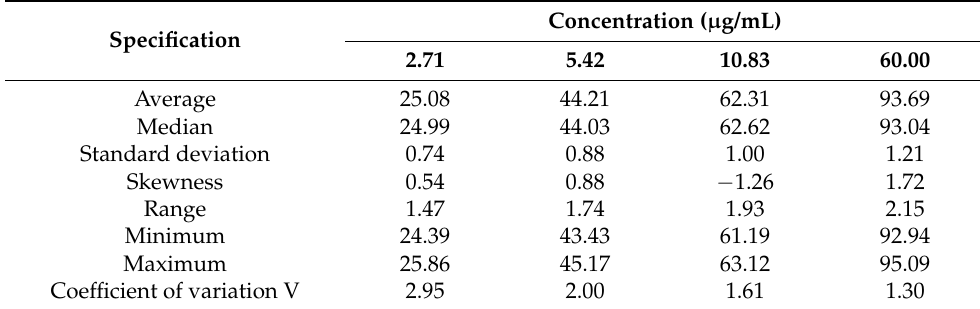
Table 10. DPPH radical scavenging activity of standard solution (BHA) (experiment with the aerial part of the plant).